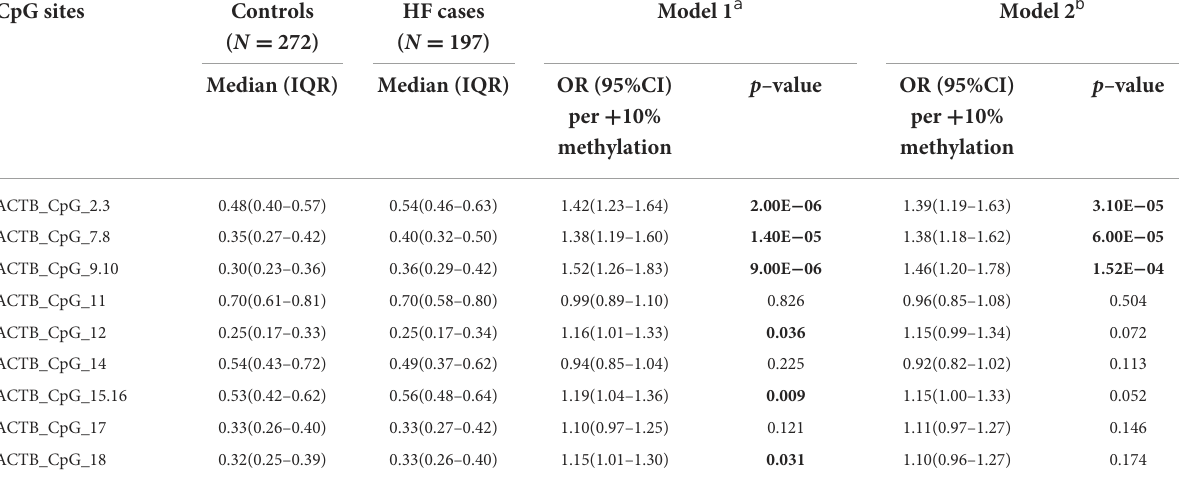
TABLE 6 Methylation difference of ACTB between HF cases and controls.